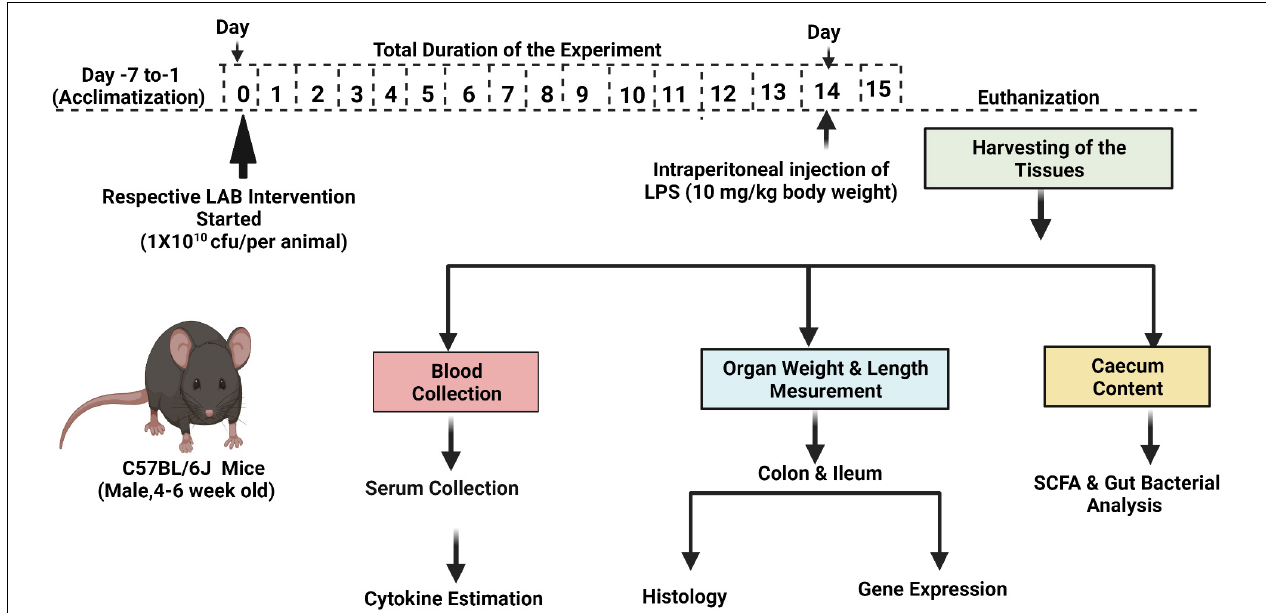
FIGURE 1 | Scheme of the